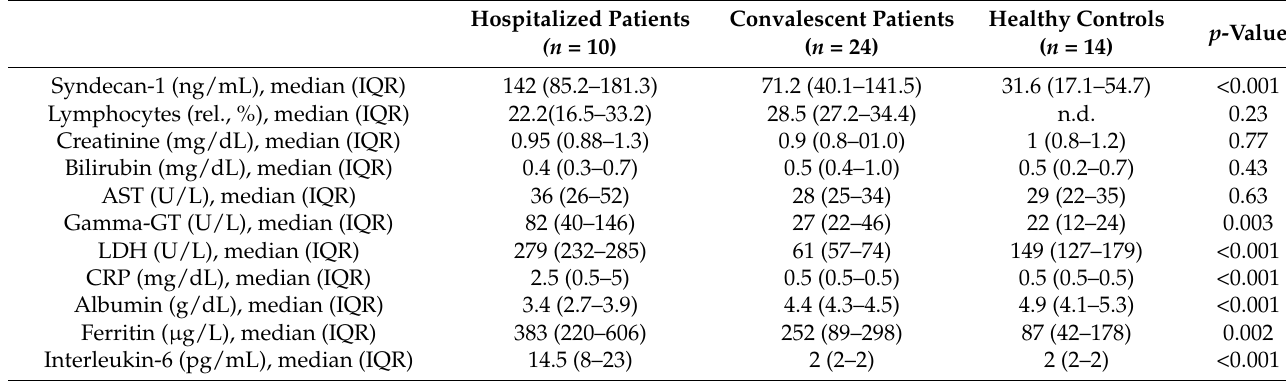
Table 2. Cohort characteristics: differences were calculated by Kruskal–Wallis test; IQR, interquartile range; LDH, lactate dehydrogenase; CRP, C-reactive protein.